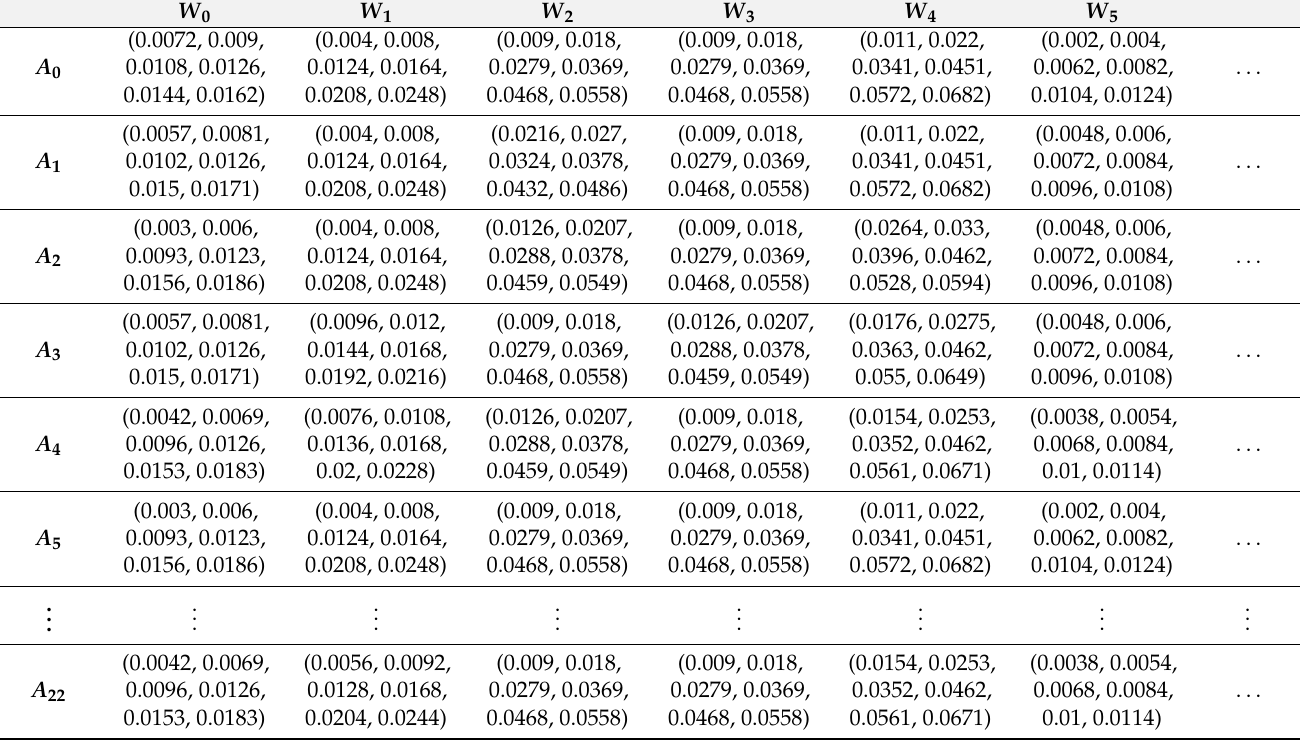
Table 10. The weighted normalized decision